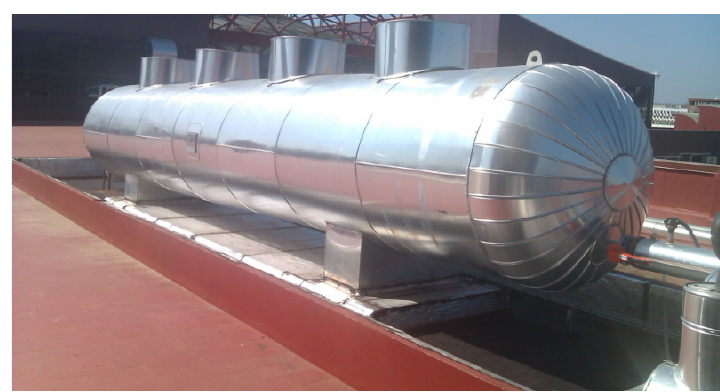
Figure 3. PCM storage